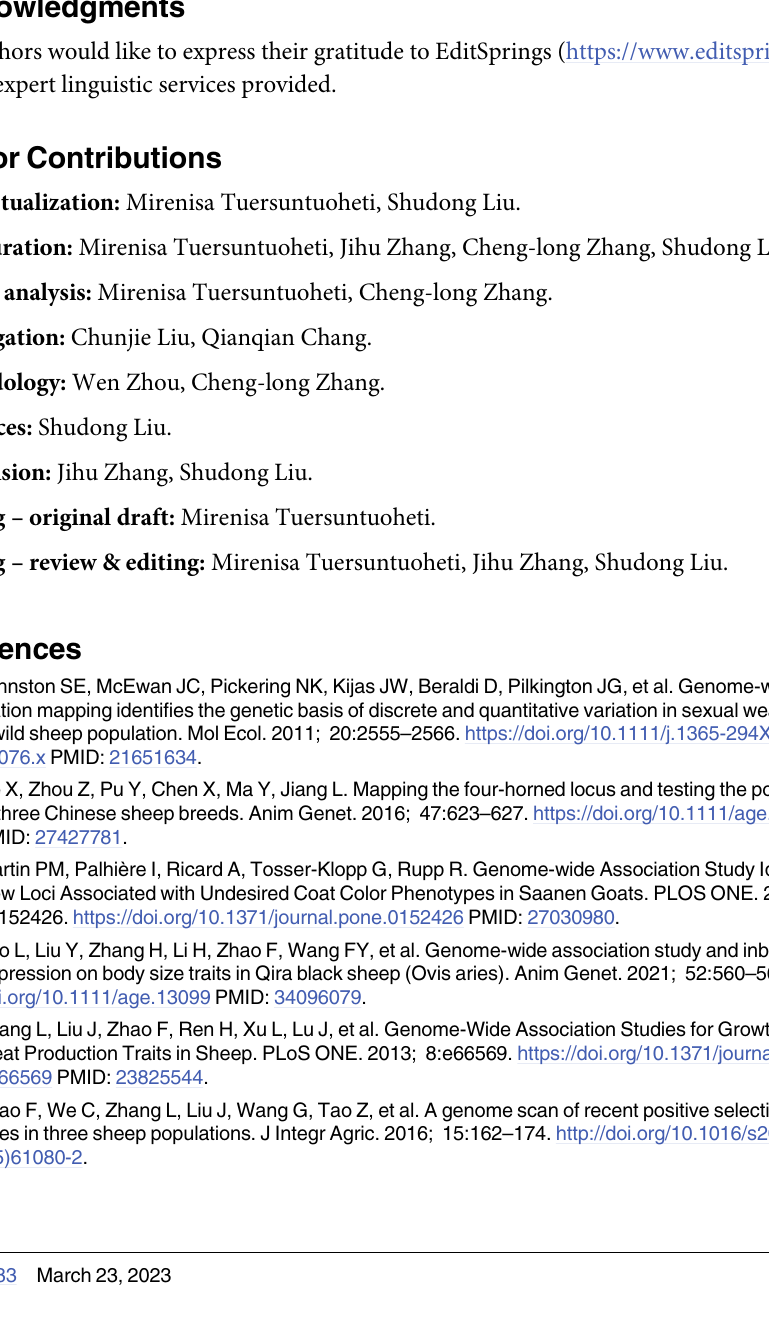
S2 Table. Data for the top 1% of SNPs from small to large were obtained from GWAS of body height. S3 Table. Data for the top 1% of SNPs from small to large were obtained from GWAS of body Weight. S4 Table. Data for the top 1% of SNPs from small to large were obtained from GWAS of chest